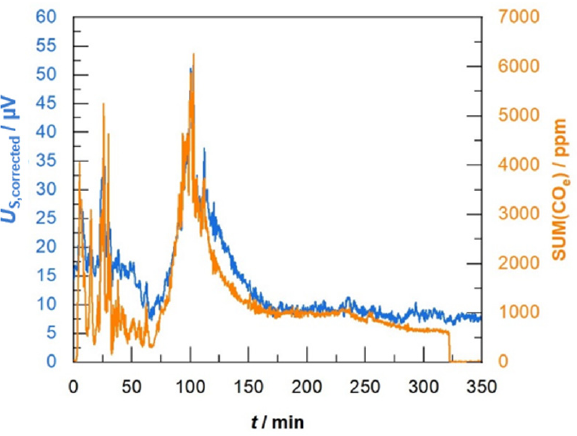
Figure 7. Corrected sensor signal (sensor type Gen_1) in comparison to analytic data (sum of CO e measured by FTIR and weighted as described in the text).